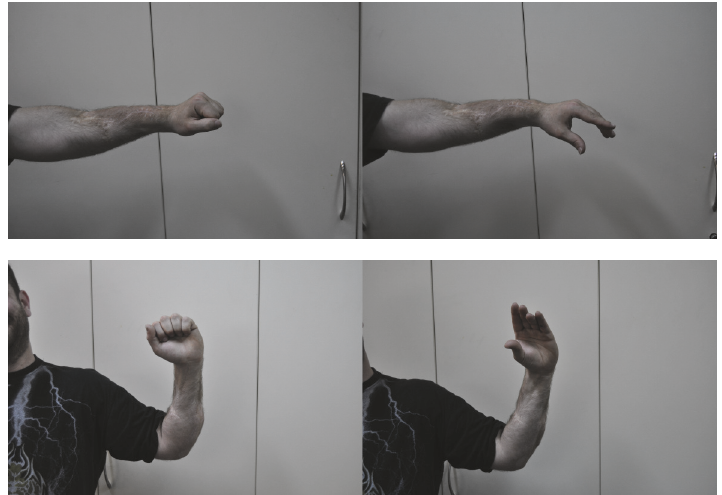
Figure 3: Two years after the final operation. The surgical wound has healed uneventfully. The patient can extend his wrist and fingers, and the thumb is out of the